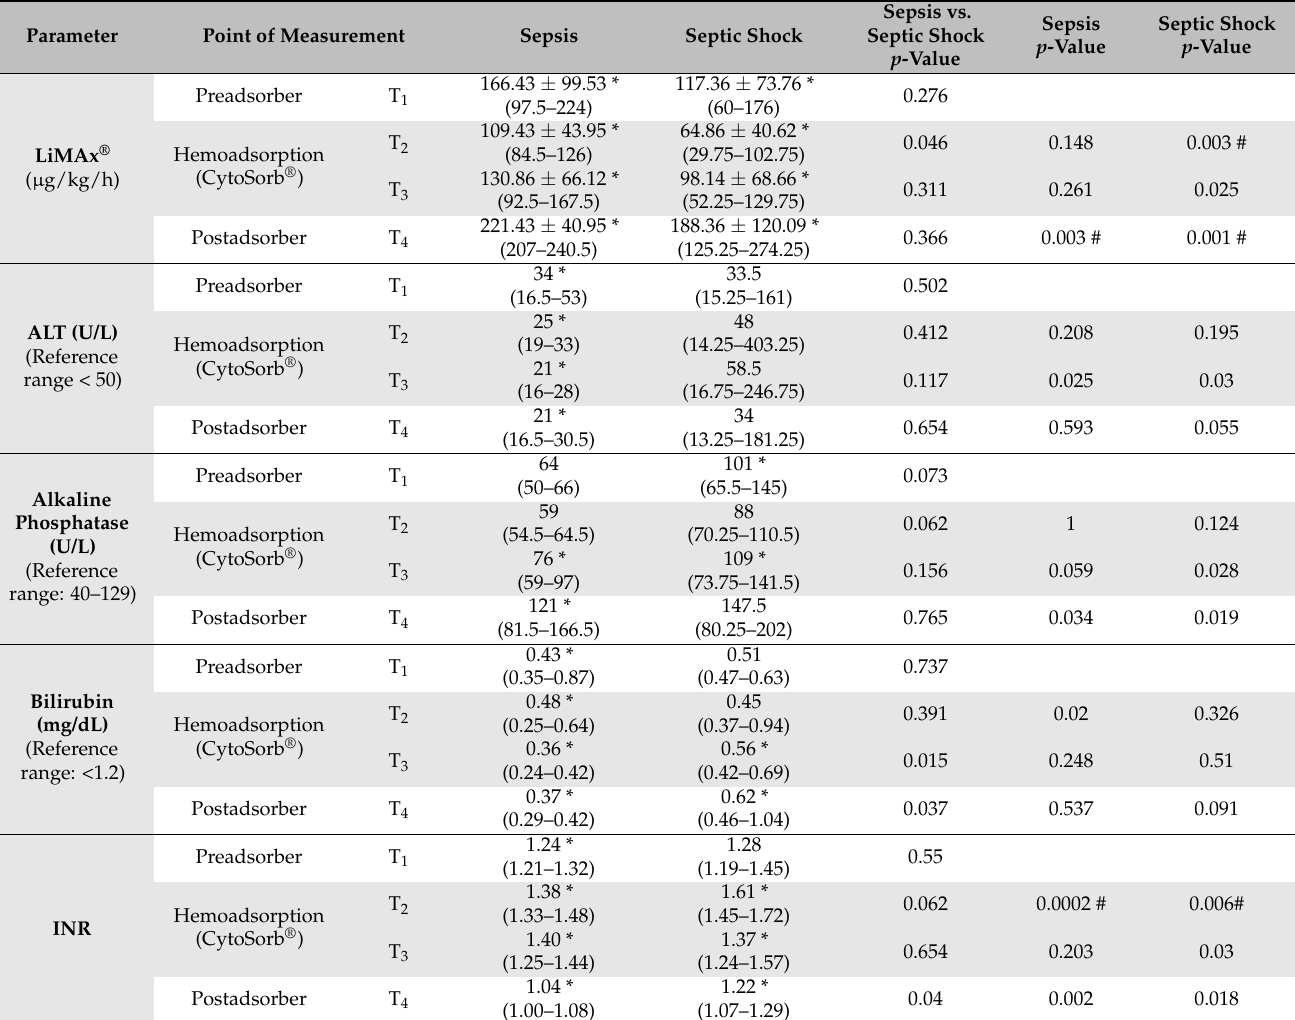
Table 2. LiMAx ® values and parameters of hepatocellular damage, cholestasis and synthesis in sepsis and septic